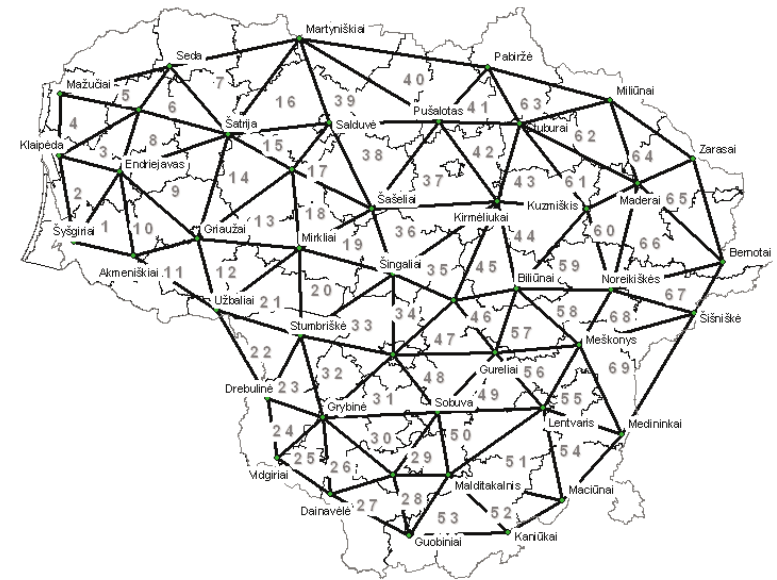
Fig. 1. Scheme of continues measurements of